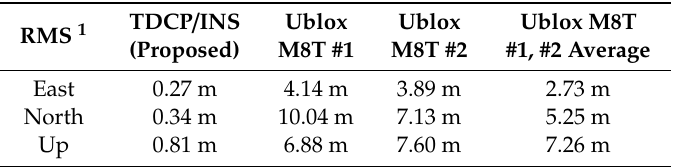
Table 2. Maximum errors of the proposed method with other filtered solutions.